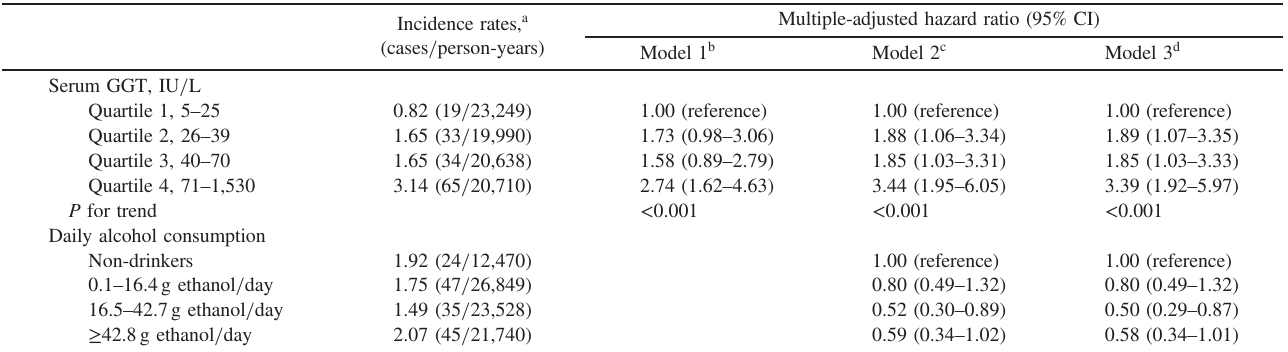
Table 2. Multivariate model of the incidence of persistent proteinuria according to baseline serum GGT and alcohol consumption ( n = 9,341) Incidence rates, a